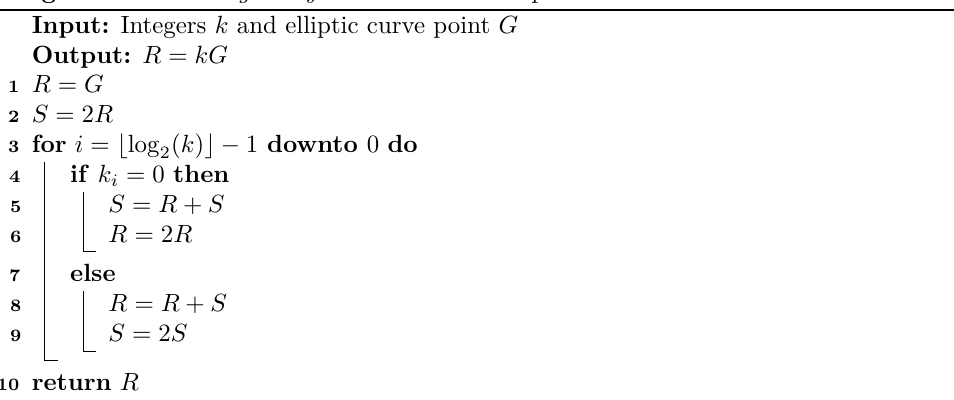
Algorithm 3: Montgomery ladder scalar